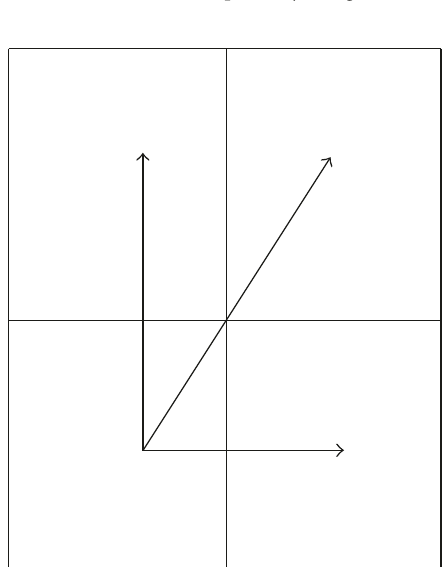
Figure 4: Match the peaks by using DTW.